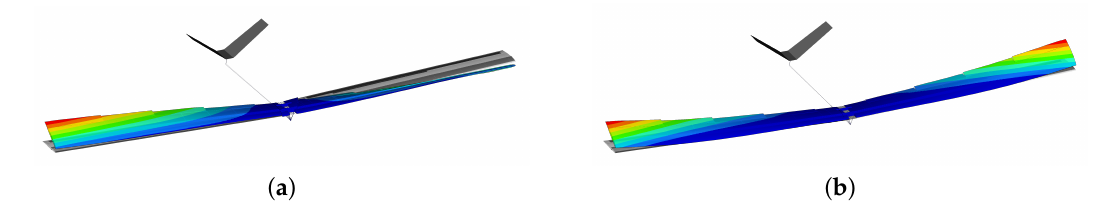
Figure 12. Flutter modes result at 66.0ms − 1 . ( a ) Flutter mode-9, antisymmetric torsion; ( b ) Flutter mode-11, symmetric